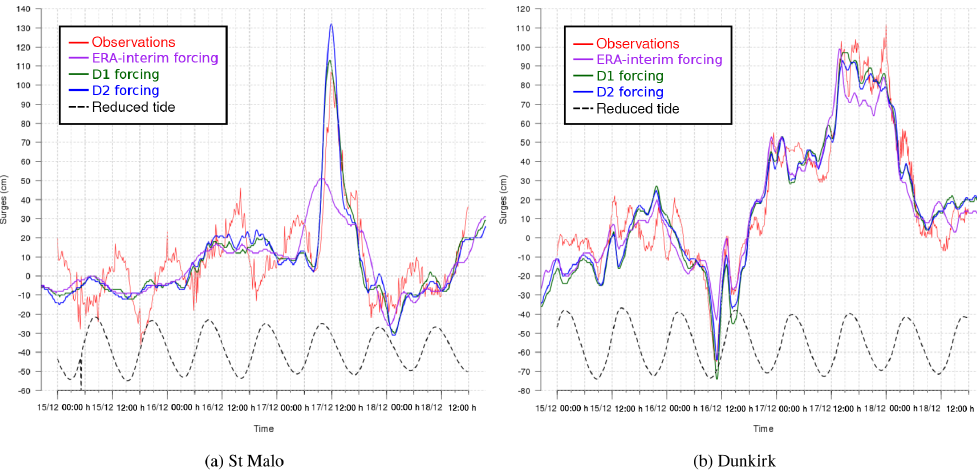
Figure 9. Storm surges (centimetres) at St Malo (a) and Dunkirk (b) from 14 December 2004 at 15:00UTC to 19 December 2004 at 06:00UTC. The measured surge (red line), the reconstructed surge by using the ERA-Interim forcing (purple line), the D1 forcing (green line) and the D2 forcing (blue line) are superimposed. The oscillatory dotted line in the lower part of the graph is used to indicate the time of high and low tides.